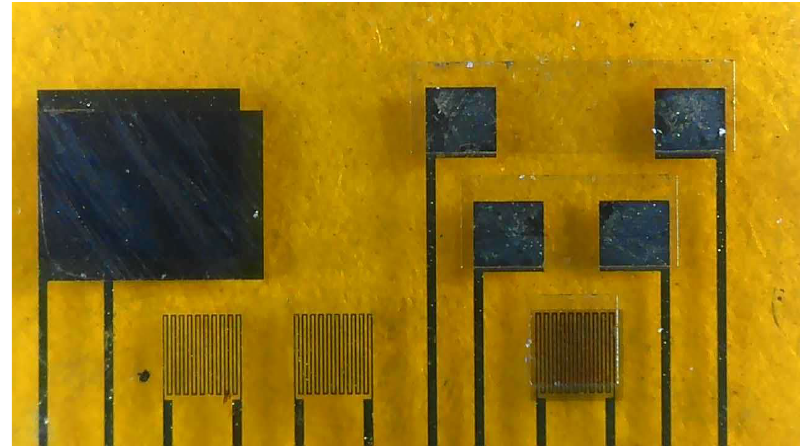
Figure 2. Optical micrograph of the flexible 7-in-1 microsensor.